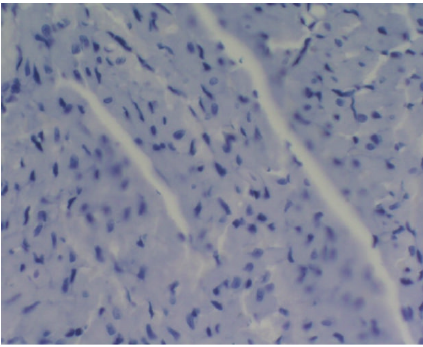
Figure 4: Baicalin-treated group-6h Bax × 200 (positive expres- sion).